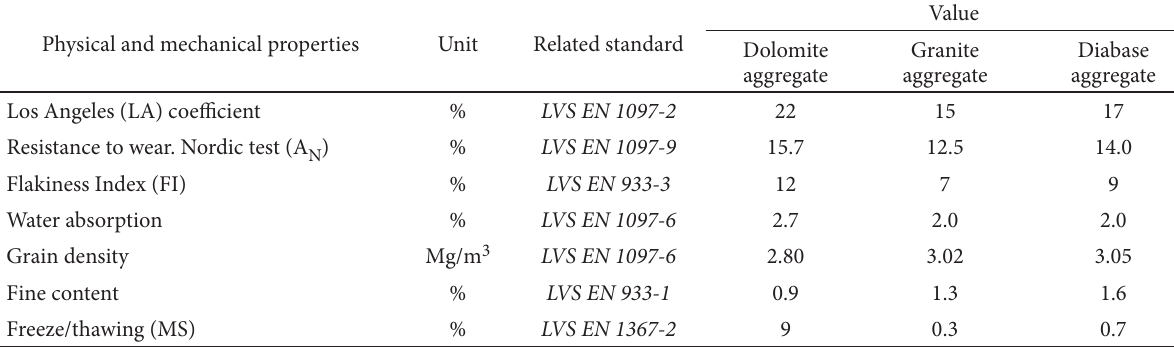
Value Dolomite Granite Diabase aggregate aggregate aggregate